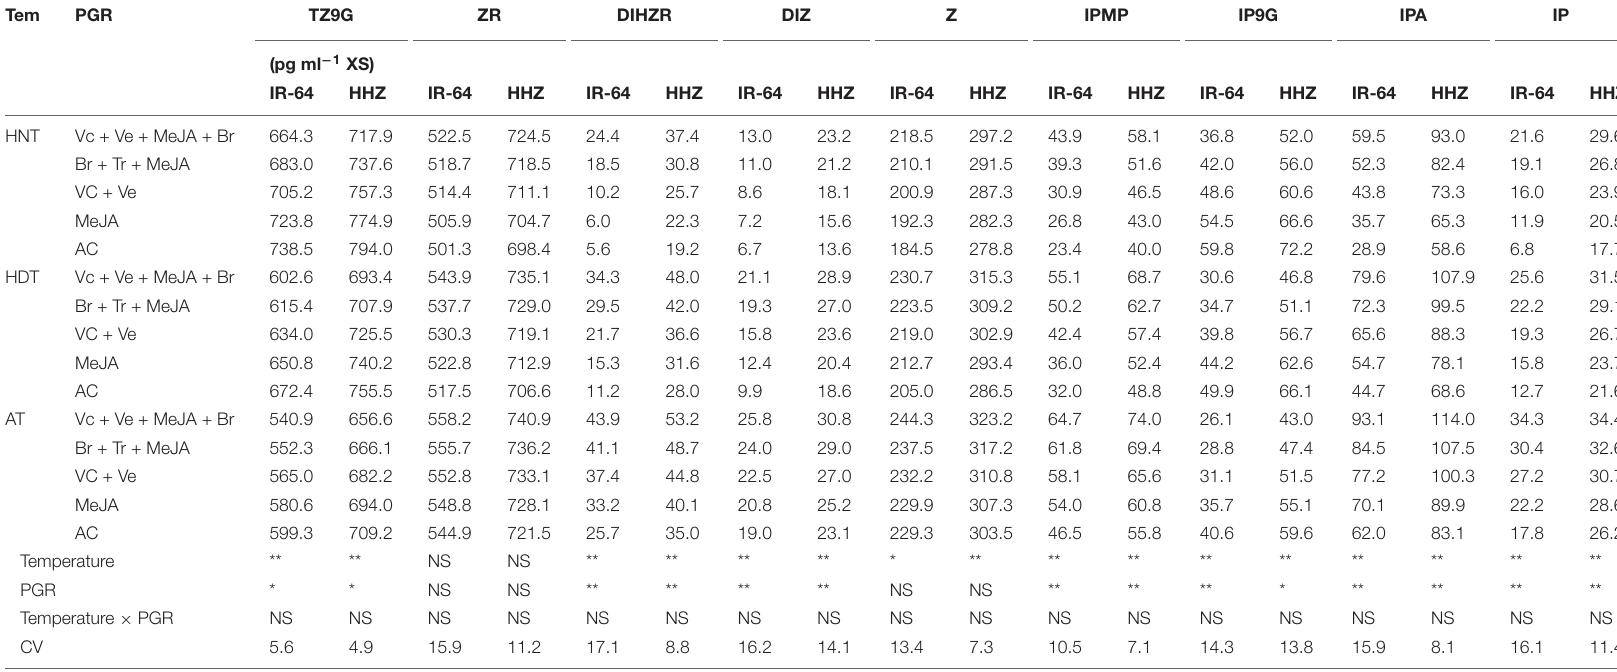
TABLE 5 | Impact of plant growth regulators on hormones content in xylem sap of rice under heat stress at heading stage. Tem PGR